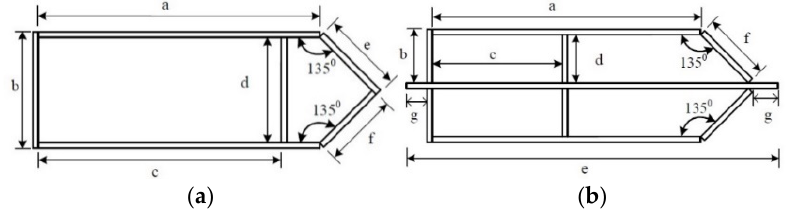
Table 1. Dimensions of test specimens.